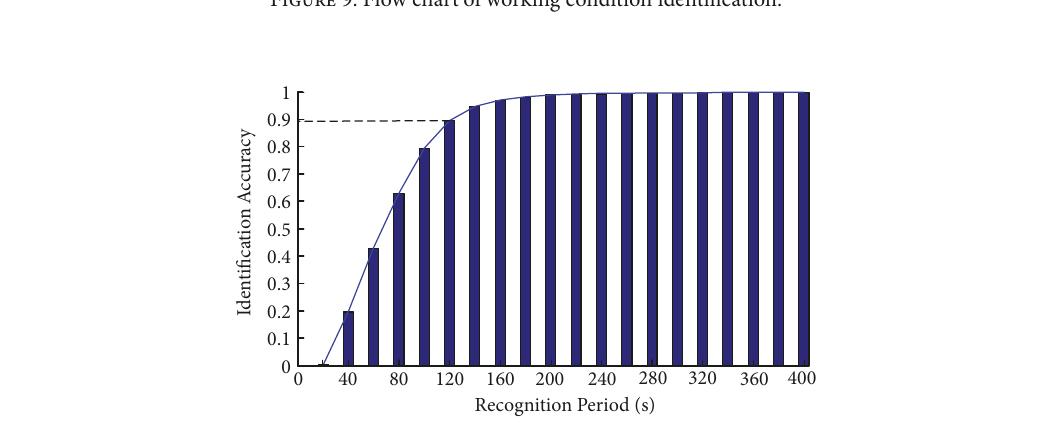
Figure 9: Flow chart of working condition identification.